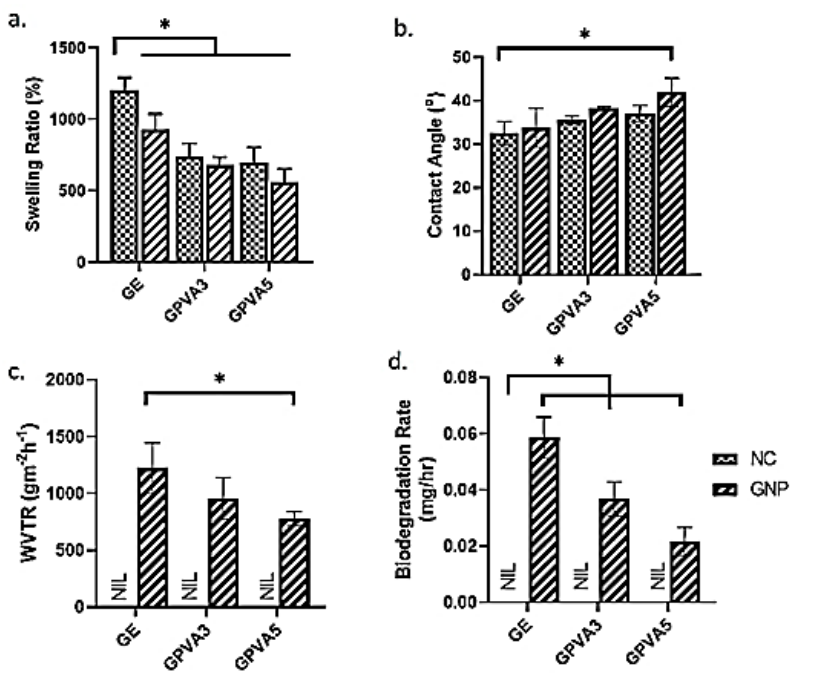
Figure 3. Physicochemical analysis of GE, GPVA3, and GPVA5 ( a ) % of swelling ratio (°), ( b ) contact angle, ( c ) water vapor transmission rate (WVTR) (gm − 2 h − 1 ), and ( d ) biodegradation rate. * indicates p < 0.05.